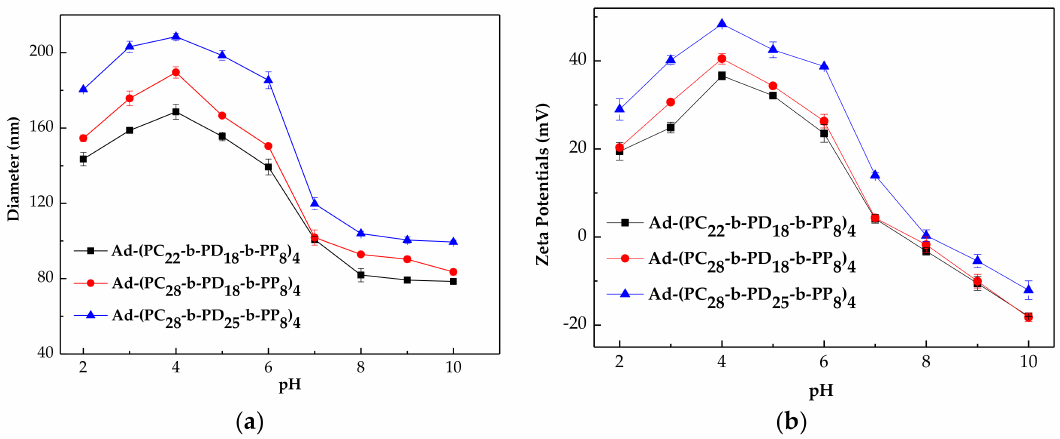
Figure 5. Effects of pH on the D h ( a ) and zeta potential ( b ) of star polymeric